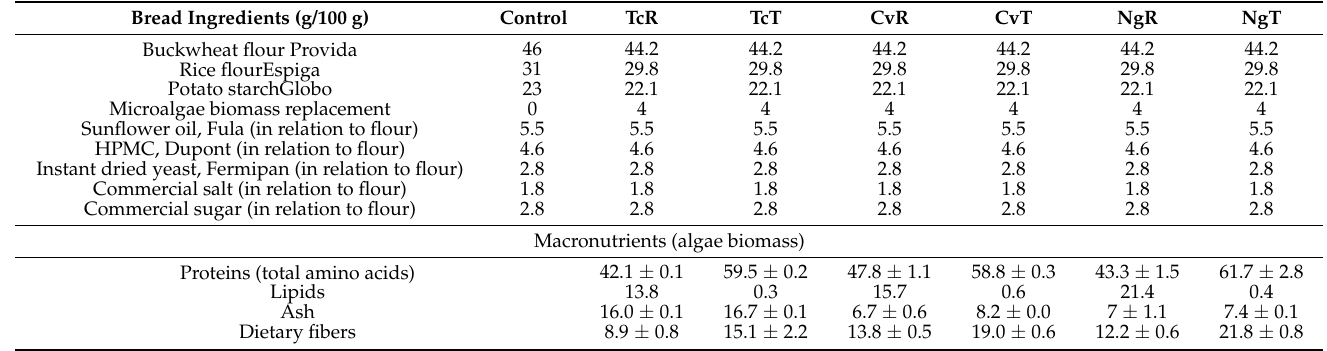
Table 1. Formulation of the breads and macronutrient composition (%) of the raw ingredients used for the control and different 4% microalgae biomass-replaced breads. Tetraselmis chuii (TcR), Tetraselmis chuii ethanol-treated (TcT), Chlorella vulgaris (CvR), Chlorella vulgaris ethanol-treated